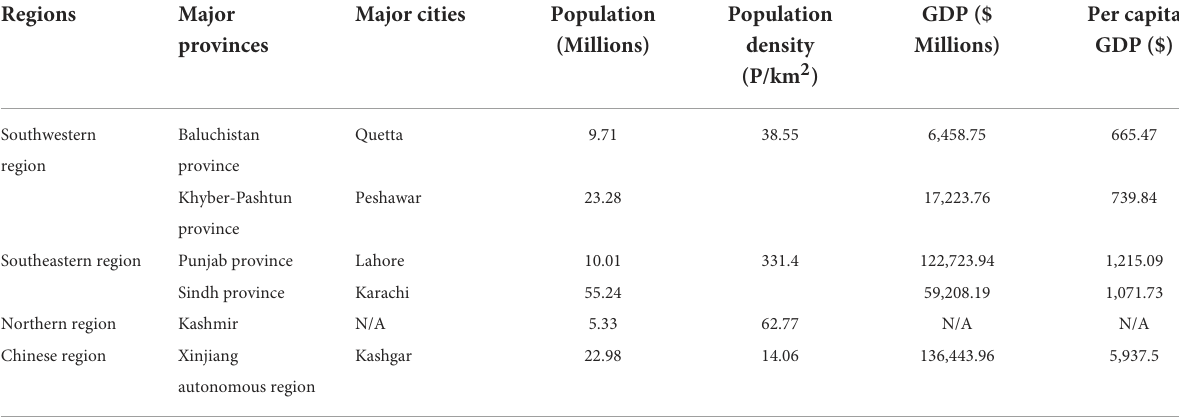
TABLE 1 Socioeconomic data of the China-Pakistan Economic Corridor (CPEC) regions. Regions